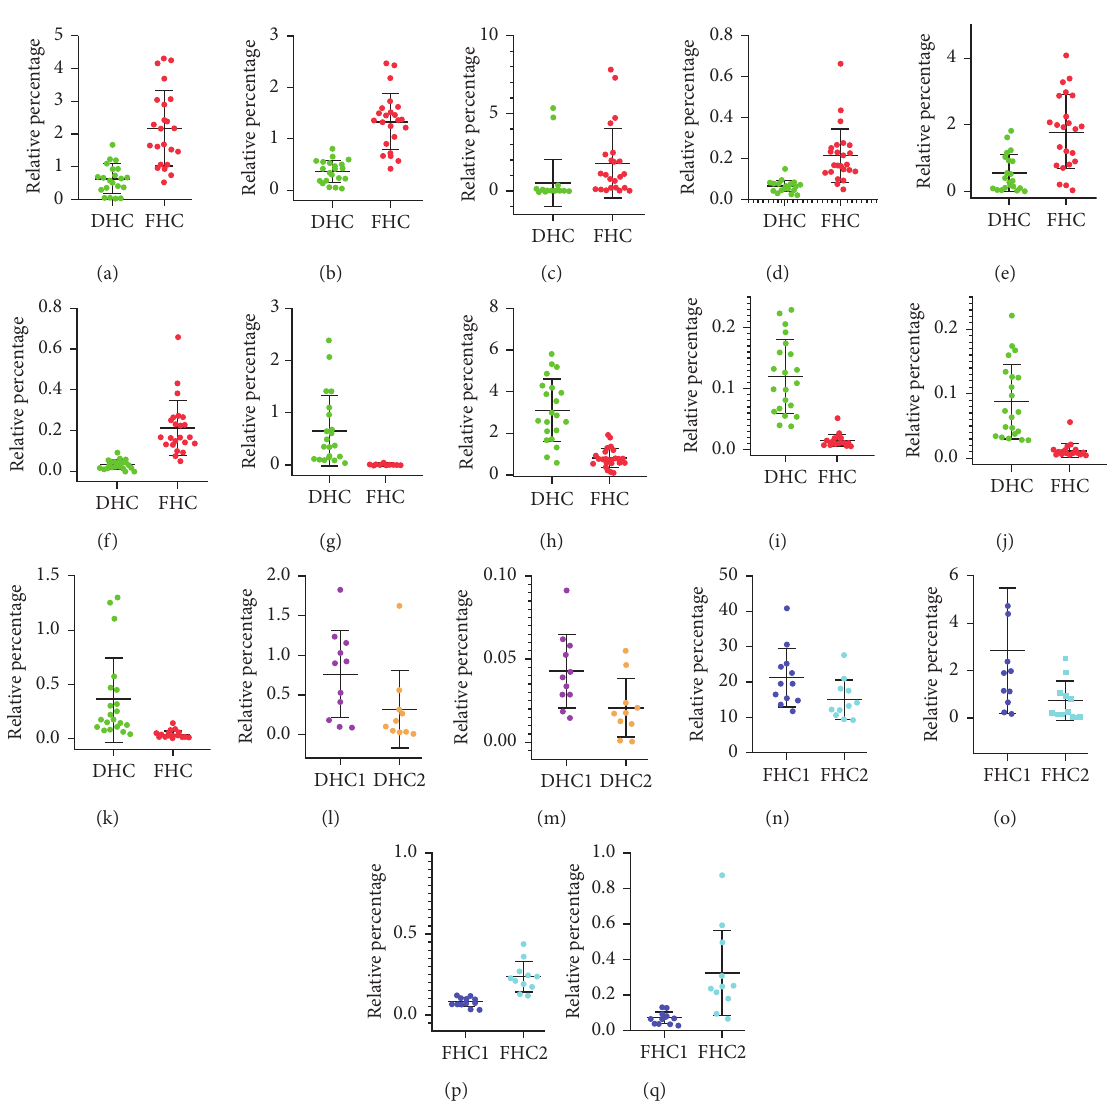
Figure 5: Relative content of chemical markers of DHC and FHC (a–k), DHC1 and DHC2 (l, m), and FHC1 and FHC2 (n–q). (a) α -Pinene; (b) limonene; (c) β -phellandrene; (d) α -terpineol; (e) 4-tridecanone; (f) ethyl decanoate; (g) nonanal; (h) 1-nonanol; (i) β -cyclocitral; (j) n-hexadecanoic acid; (k) octadecanol; (l) 4-tridecanone; (m) ethyl decanoate; (n) β -myrcene; (o) β -phellandrene; (p) 2,6-octadien-1-ol, 3,7-dimethyl-, acetate, (z)-; (q)